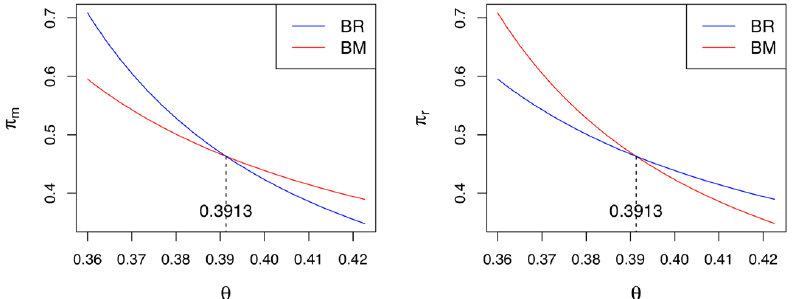
Figure 4. Comparisons between Model BR and Model BM.